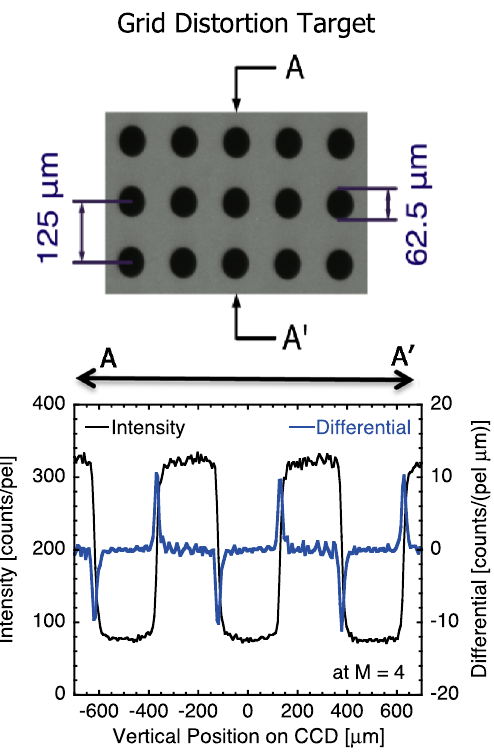
FIG. 9. Grid-distortion target and contrast data (black line) of the target image along the line from A to A 0 . The differentiation data (blue line) are also depicted.